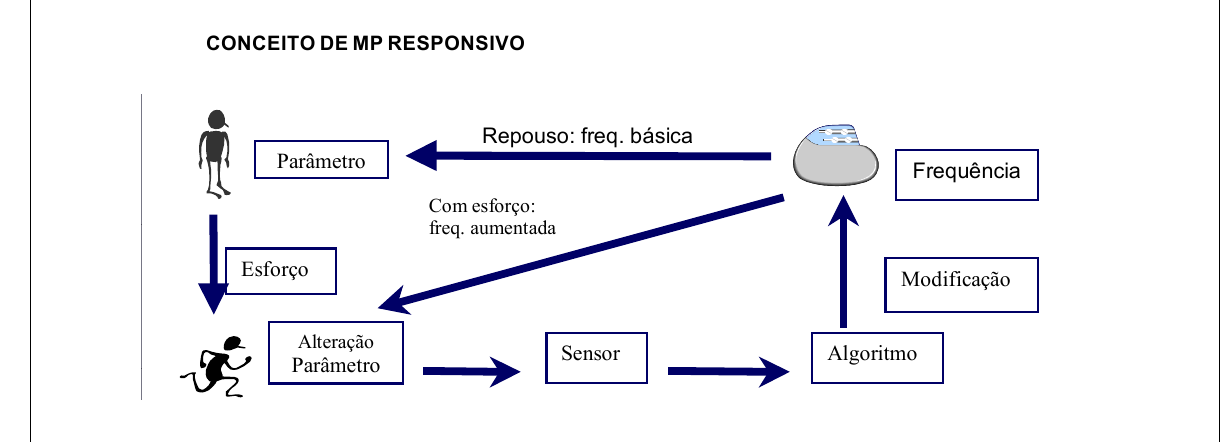
Fig. 1 – Esquema básico do funcionamento do MP responsivo, onde as alterações geradas pelo esforço são registradas pelo sensor, que modifica a freqüência de estimulação do MP, adaptando-a ao esforço produzido.